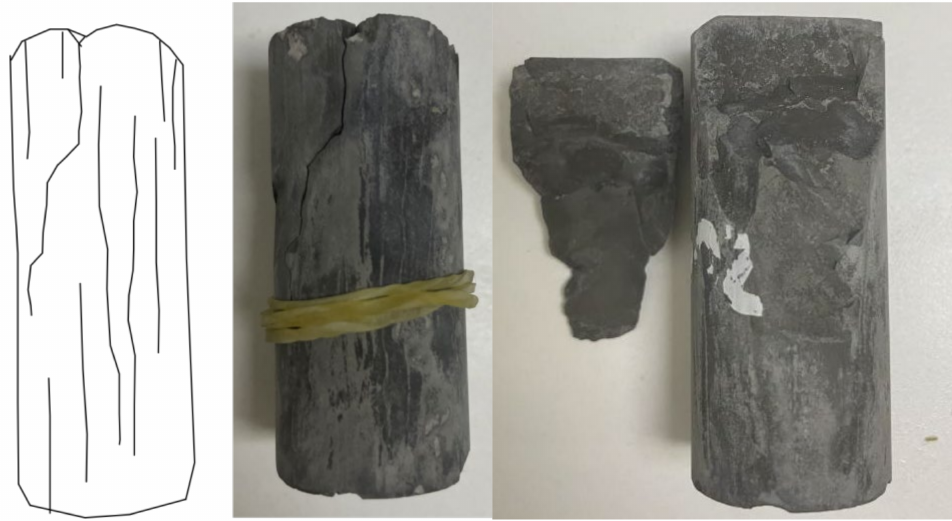
Figure 2. Observation on the internal lamination of a shale